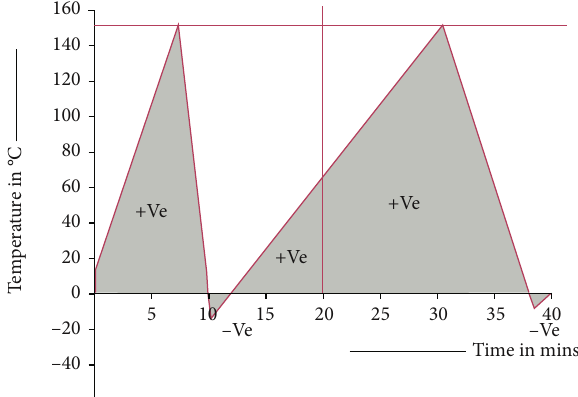
Figure 3: Thermal cyclic pro fi le curve during various thermal cycles.